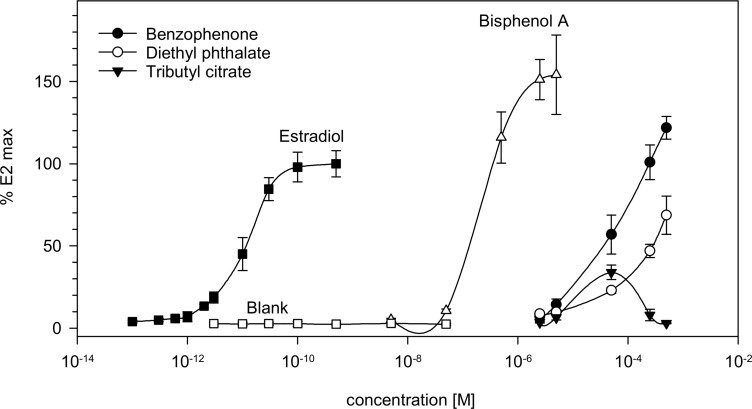
Analysis of detected pure substances in ER-CALUX®: Response of bisphenol A (BPA), diethylphthalate (DEP), tributyl citrate (TBC) and benzophenone in comparison to natural estrogen 17β-estradiol and a solvent blank.The y-axis (“E2 max”) refers to the relative luciferase activity compared to the highest signal determined in the standard curve of 17β-estradiol (E2). The two highest concentrations of TBC led to a decrease in cell viability leading to decreased activities in the assay.